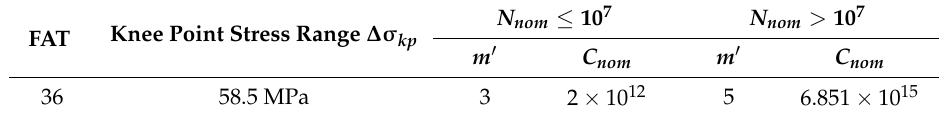
Figure 16. FAT36 curve.